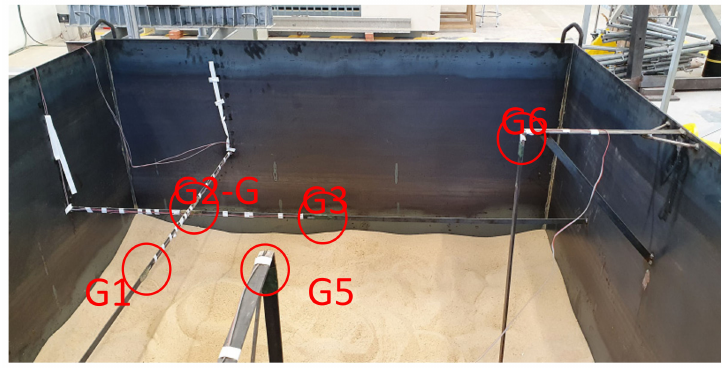
Figure 11. Gauge layout in pool.